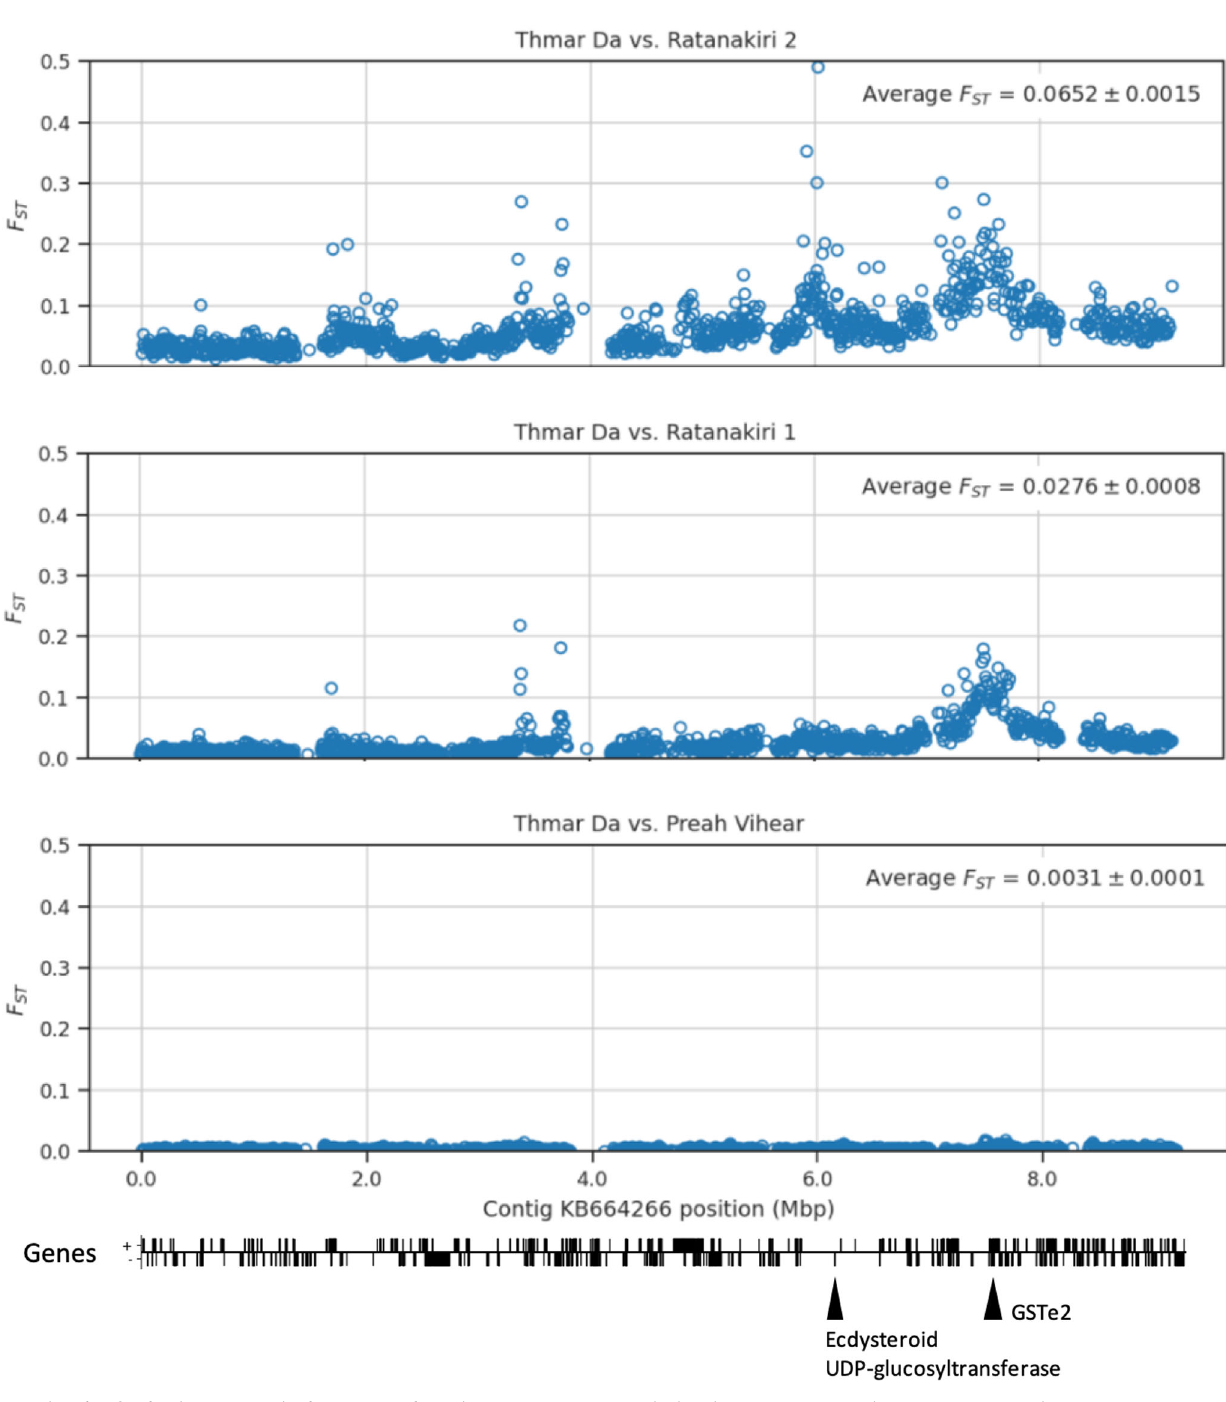
Fig. 3 Signals of selection over a single autosomal contig. Pairwise Fst was calculated in 1000 SNP windows over autosomal contig KB664266, comparing the Thmar Da population to the three other populations, Ratanakiri 2, Ratanakiri 1, and Preah Vihear. There is almost no indication of selection when comparing Thmar Da with Preah Vihear. There is a strongly supported signal of differentiation in both Ratanakiri 1 and Ratanakiri 2 populations at 7.5 Mbp, which is in the same location as a cluster of GSTe genes, including GSTe2 , which are known to be involved in metabolic resistance to DDT and pyrethroids. The signal with the highest Fst peak here in RK2, at 6 Mbp is close to an Ecdysteroid UDP-glucosyltransferase gene, shown to confer pyrethroid insecticide resistance in other anophelines. These are a few of many selection signals identi fi ed in this study that may be associated with insecticide pressure on these An. minimus